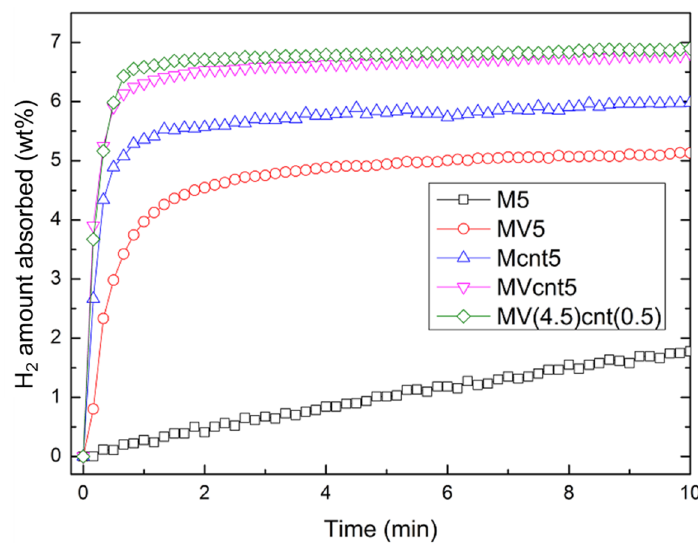
Figure 6. Hydrogen absorption of the different MgH 2 -based composites at 200 °C with an initial pressure of 2.0